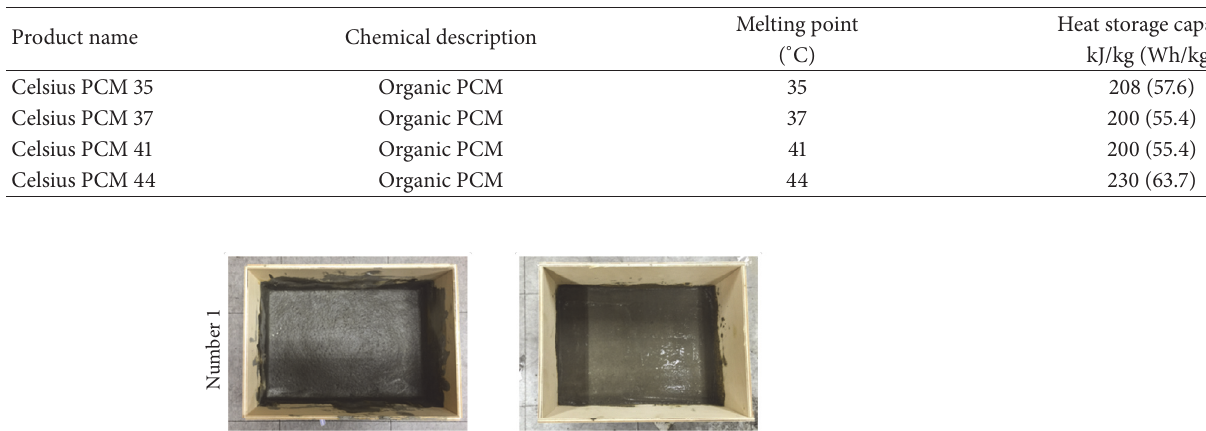
Table 2: Thermal characteristics of PCM in each temperature range [48].